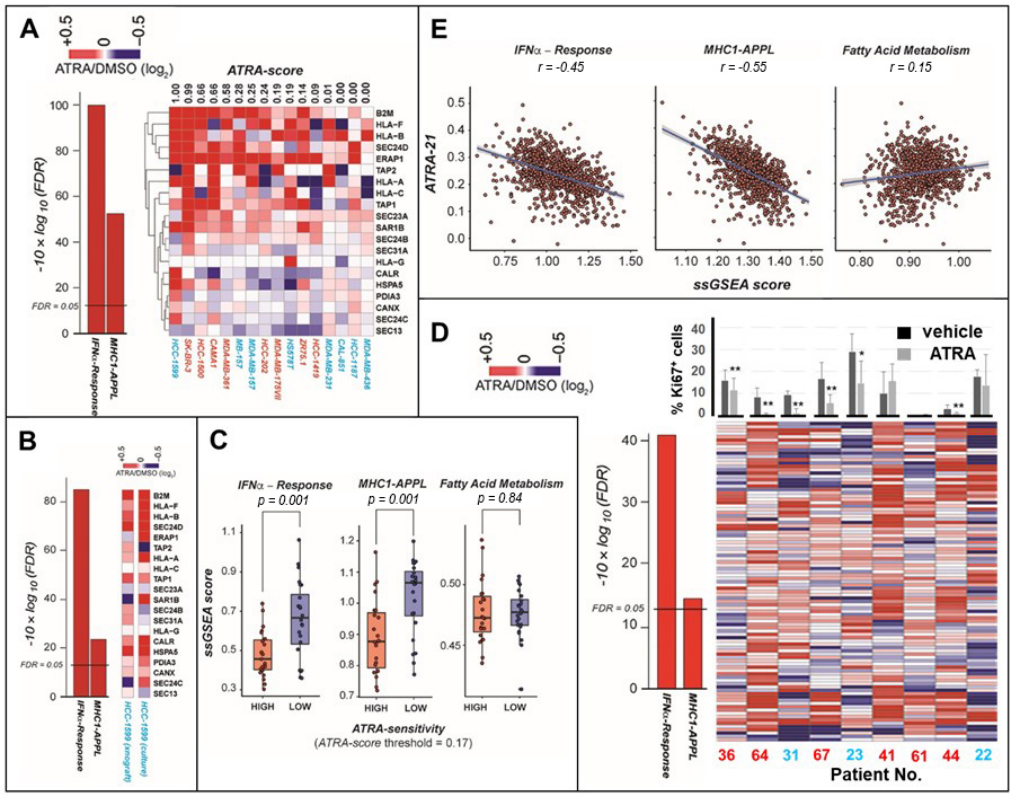
Figure 4. ATRA-related upregulation of antigen-presentation and interferon- α genes in breast cancer. ( A ) The left graph indicates the enrichment of the two indicated gene networks. The horizontal line indicates the FDR (False Discovery Rate) threshold value. The heat-map on the right illustrates the e ff ects of ATRA on the “ MHC1-APPL ” ( Antigen-Presentation Folding Assembly and Peptide-Loading of Class-I MHC ) gene set. The cell-lines are ordered according to the ATRA-score from left to right. The ATRA-score values are shown above the heat-map. Luminal and basal cell-lines are marked in red and blue, respectively. ( B ) The left graph illustrates the ATRA-dependent enrichment of “ IFN α -Response ” and “ MHC1-APPL ” gene sets in the xenografts of HCC-1599 cells. The two heat-maps on the right compare the e ff ects of ATRA on the “ MHC1-APPL ” gene set in HCC-1599 cell-cultures and xenografts. ( C ) Using the CCLE (Cancer Cell-Line Encyclopedia) RNA-seq data, the constitutive expression levels of the “ IFN α -Response ”, “ MHC1-APPL ” and “Fatty Acid Metabolism” (negative control) gene sets were